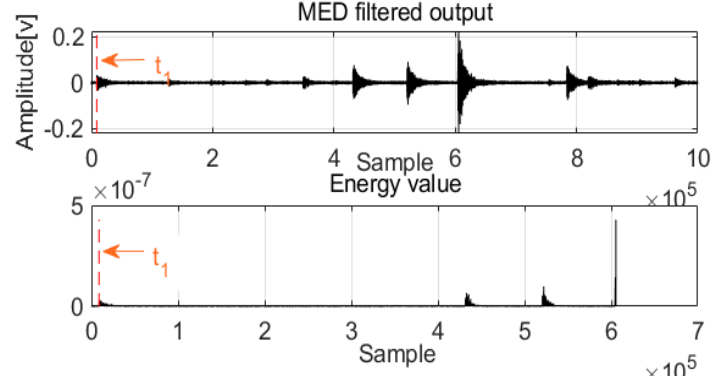
Figure 4. The first arrival time for Channel 1.